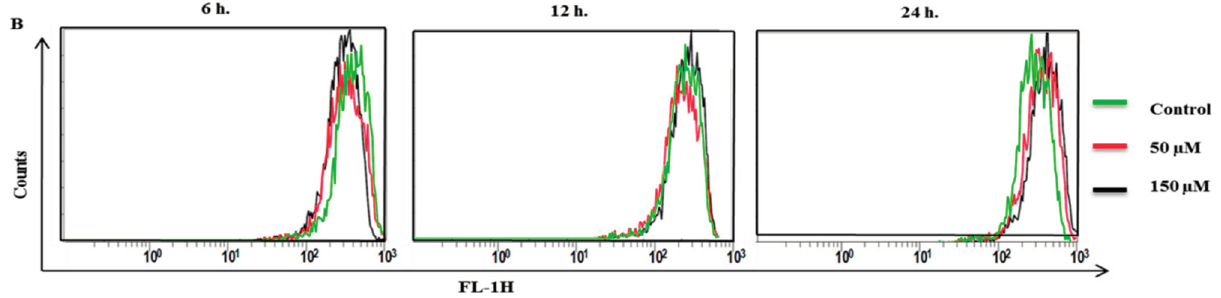
Figure 6. Effects of Poncirin on MMP ( ΔΨ m), and mitochondrial apoptosis regulatory proteins in AGS cells ( A ).Western blot analysis for the effects of Poncirin on Bak, caspase-9, Bax and Bcl-xL. The results are from one representative of three independent experiments that showed a similar pattern; and ( B ) AGS cells were incubated at indicated concentrations of Poncirin for 6, 12 and 24 h. Cells were stained with